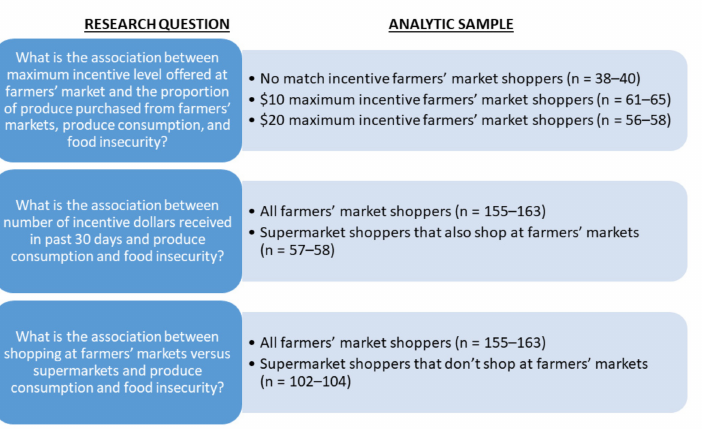
Figure 1. Analytic sample used to answer each research question in the California Nutrition Incentive Program evaluation study n’s vary due to different outcomes having slightly different analytic sample sizes due to variables required to run the